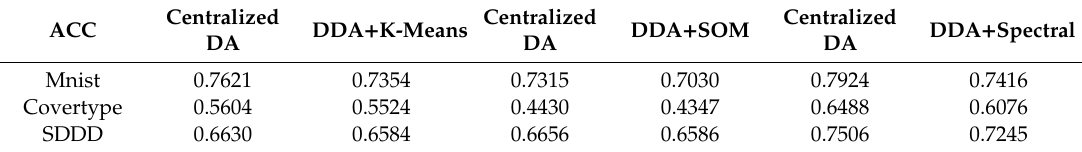
Table 4. Performance of the DDA clustering algorithm.